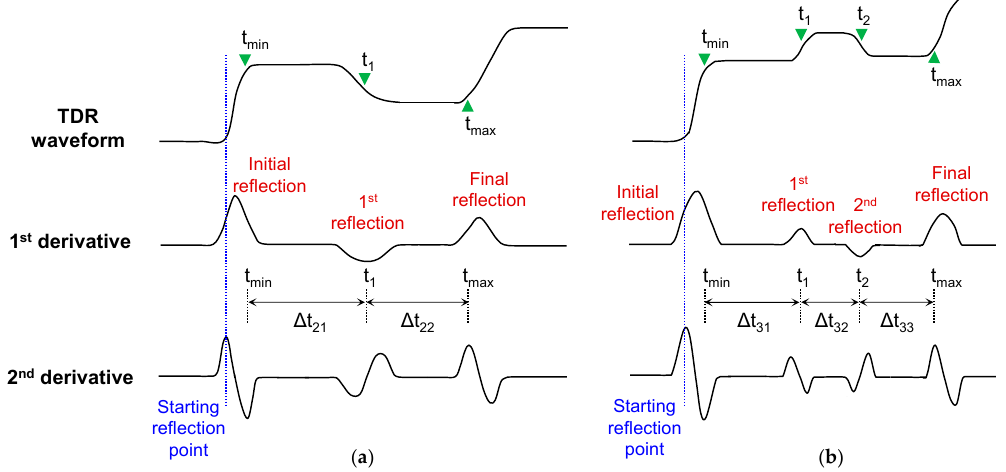
Figure 6. Typical TDR waveforms and the variation of first and second order derivatives in: ( a ) two segments (DW); ( b ) three segments (WDW).